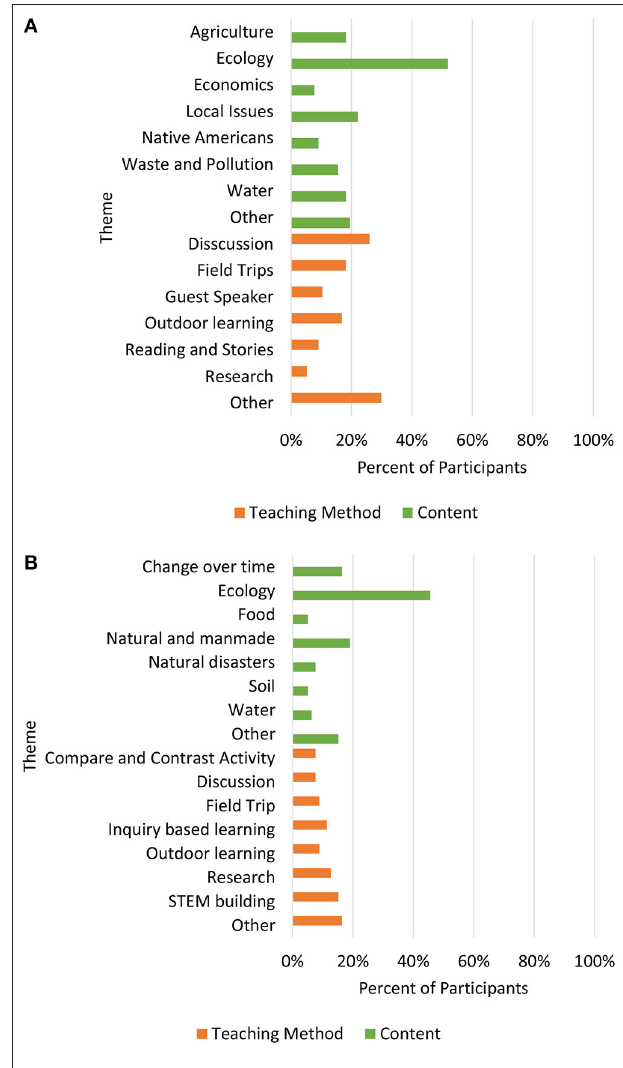
FIGURE 8 | The percent of participants that mentioned each theme in their descriptions of an activity or lesson that they use to meet (A) Standard 1 ( n = 77) and (B) Standard 2 ( n = 79) in their